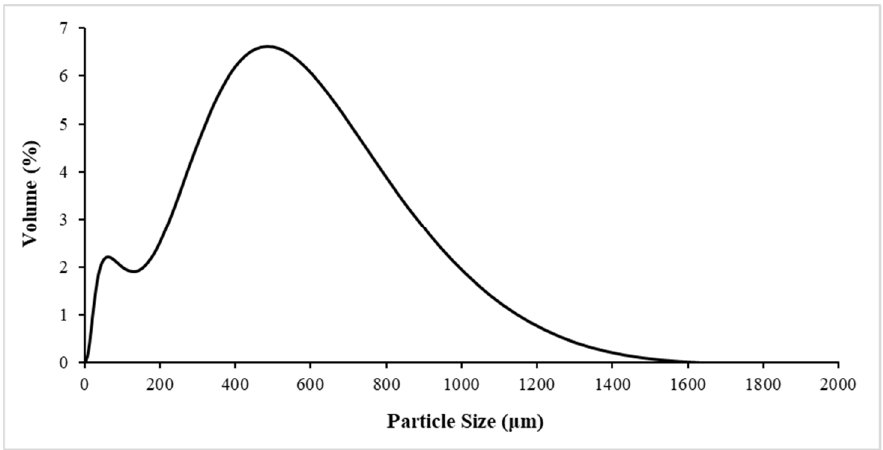
Figure 3. Particle size distribution of the OP milled sample. Table 2. d 10 , d 50 and d 90 values obtained from the milled OP sample. Raw